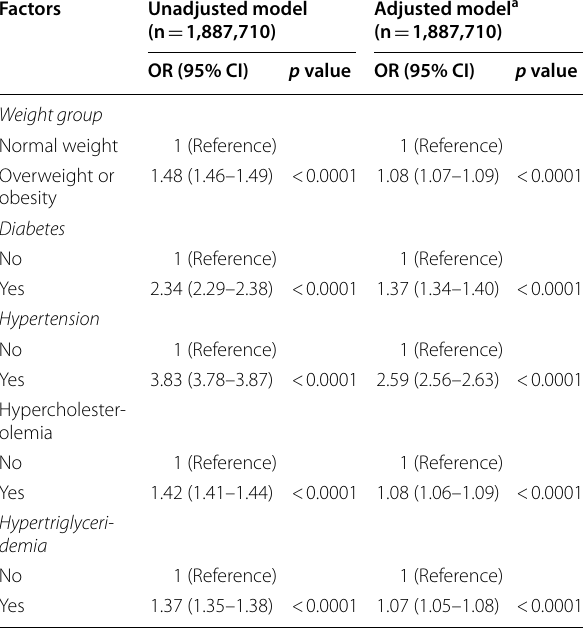
Abbreviations: CI: Confidence interval; OR: Odds ratio a All factors were incorporated into the model to adjust for each